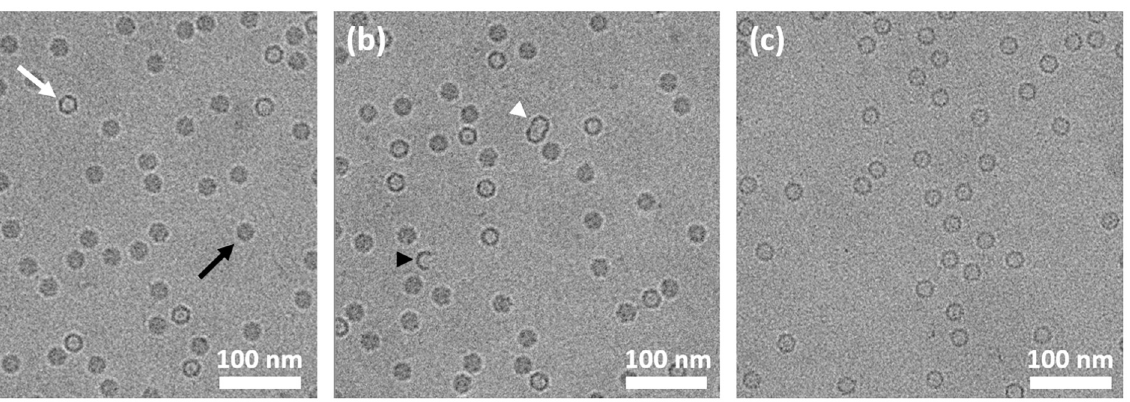
Fig 1. CryoTEM images of specimen S2.1. (a) Representative CryoTEM image of specimen S2.1 , containing filled AAV particles (black arrow) and empty AAV particles (white arrow). (b) CryoTEM image of S2.1 in which incomplete particles (black arrowhead) as well as improperly assembled particles (white arrowhead) are observed. (c) Representative CryoTEM image of AAV specimen S2.5 , reference empty. Scale bar represents 100 nm.